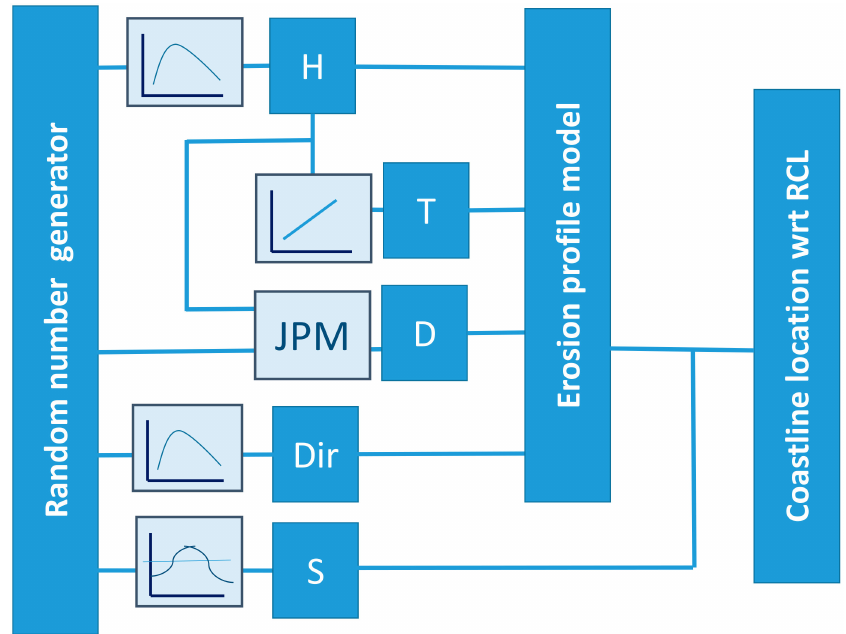
Figure 14. The scheme of the P CR model used in this study. H: maximum Hs in one storm, T: peak period associated with H, D: duration of storm, Dir: Mean direction of storm, S: Gap between two